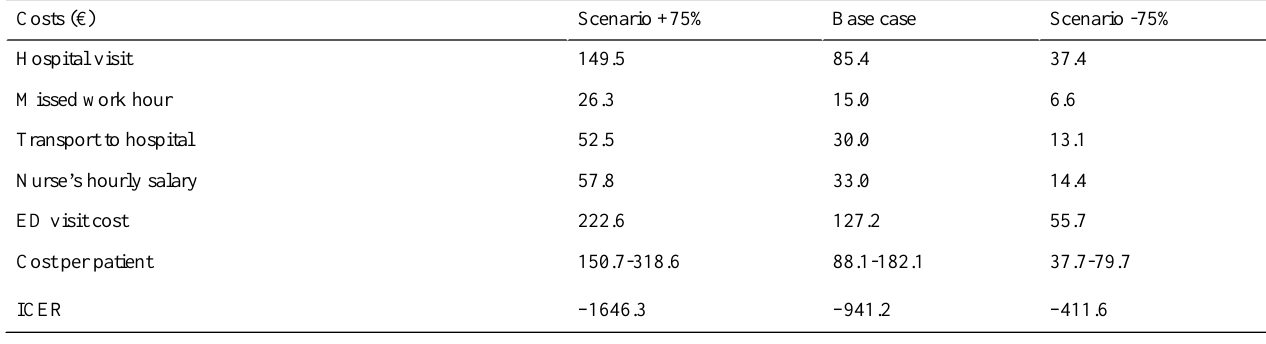
Table 4. Sensitivity analyses for two additional cost